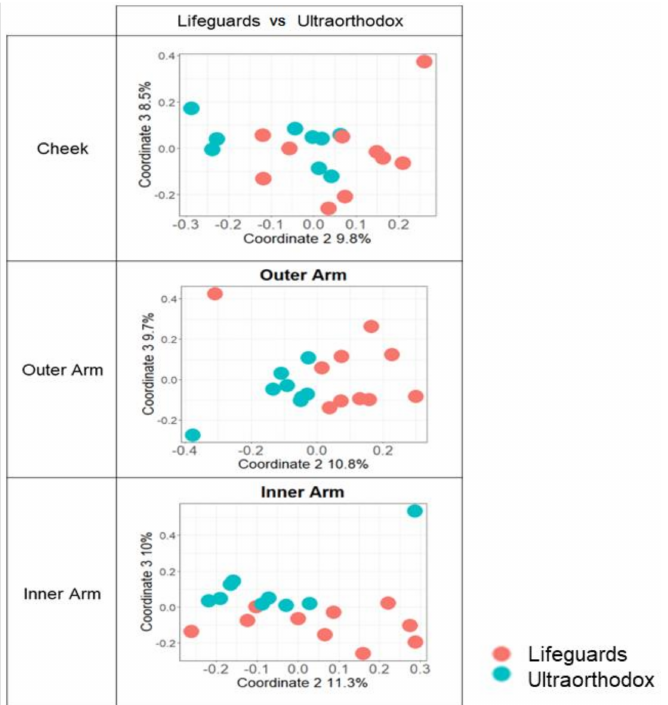
Figure 4. Beta diversity analysis of the microbiome of lifeguards versus ultraorthodox before and after summer. PcoAs of Jaccard distance matrices are shown. Blue—ultraorthodox; orange—lifeguards. Table 3. Seasonal effects on the microbiome and mycobiome. Microbiome and mycobiome dissim- ilarities were calculated for each group using Jaccard and Bray–Curtis distances. Bold indicates significant